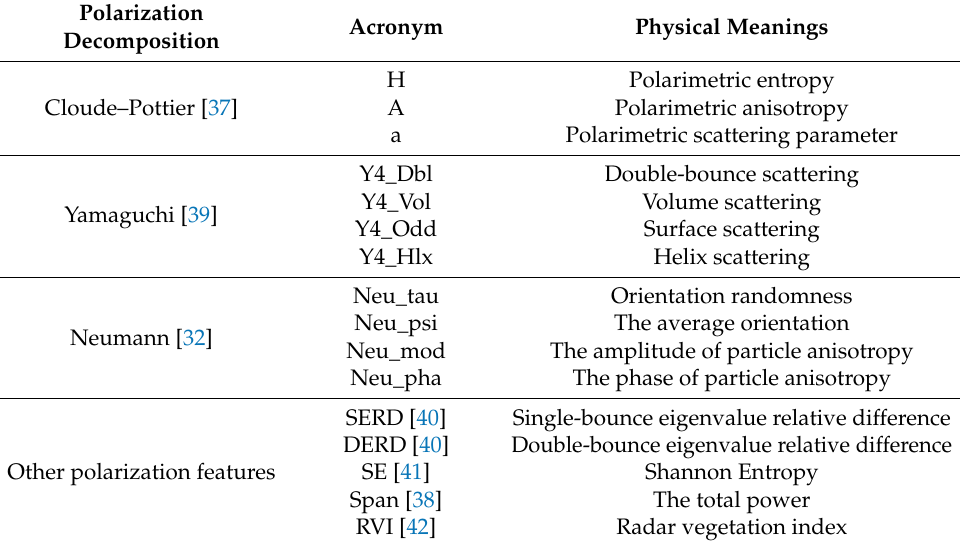
Table 2. Acronyms and description of the 16 polarimetric scattering features used in the